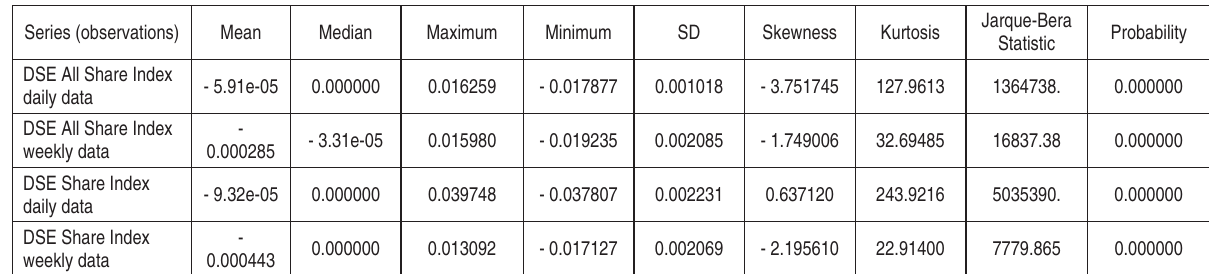
Table 1. Results of the descriptive